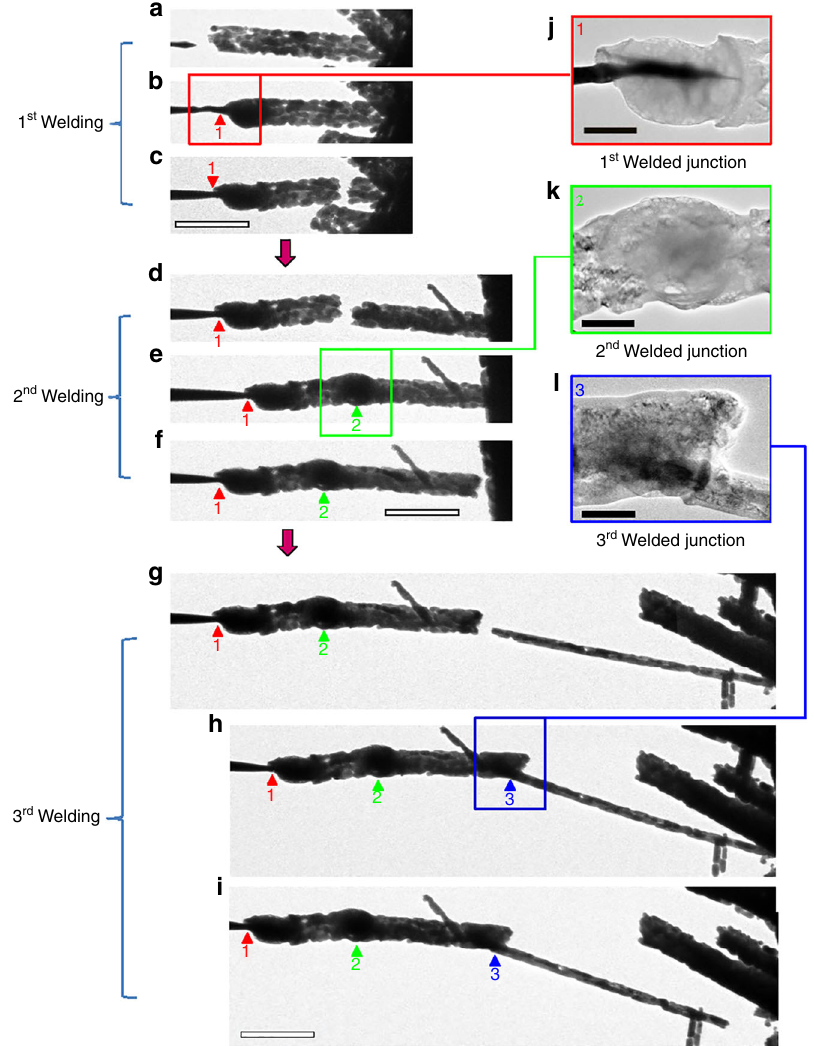
Fig. 2 The welding process of the ceramic MgO nanowires. Arrowheads and the numbers underneath them point out the welding spots. a – c The fi rst welding is the process of welding an MgO nanowire to the W tip. a A W tip approaching an MgO nanowire. b The MgO nanowire was welded to the W tip. c Tensile test on the MgO nanowire welded to the W tip. The MgO nanowire broke near the right contact. d – f The second welding: d The fi rst nanowire welded to the W tip approaching a second MgO nanowire. e The second MgO nanowire welded together with the fi rst one. f The second nanowire broke near the right contact upon tensile loading. g – i The third welding: g , the fi rst and second welded nanowires approaching a third nanowire; h The nanowire welded to a third nanowire; i The third nanowire broke near the right contact upon tensile loading. j , k, l Magni fi cations of the boxed region in b , e and h , respectively, showing the morphologies of the welded spots. Scale bars: ( a – i ) 5 μ m; ( j – l ) 200